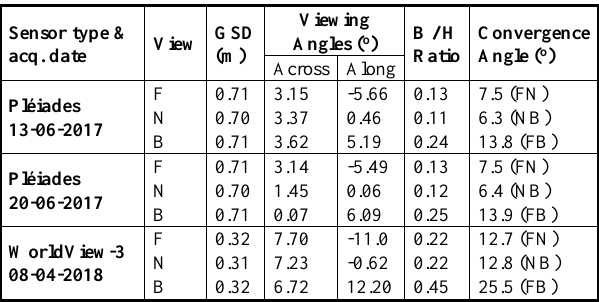
Table 1. Acquisition properties for the satellite